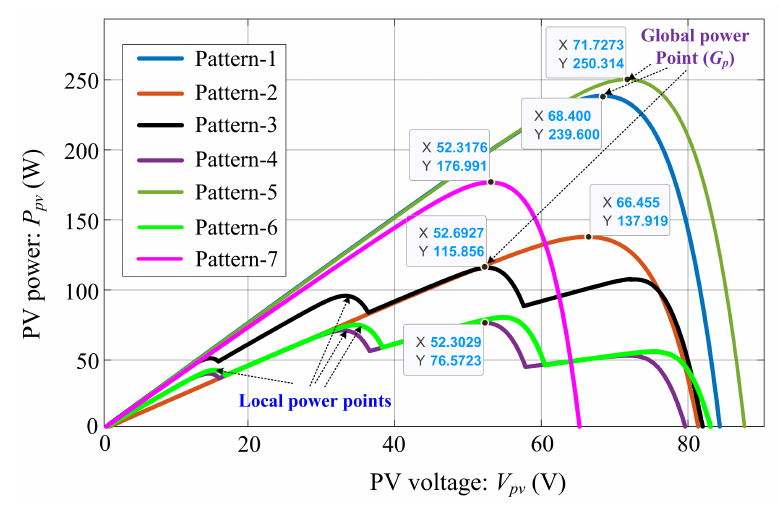
Figure 7. P–V graph for different shading